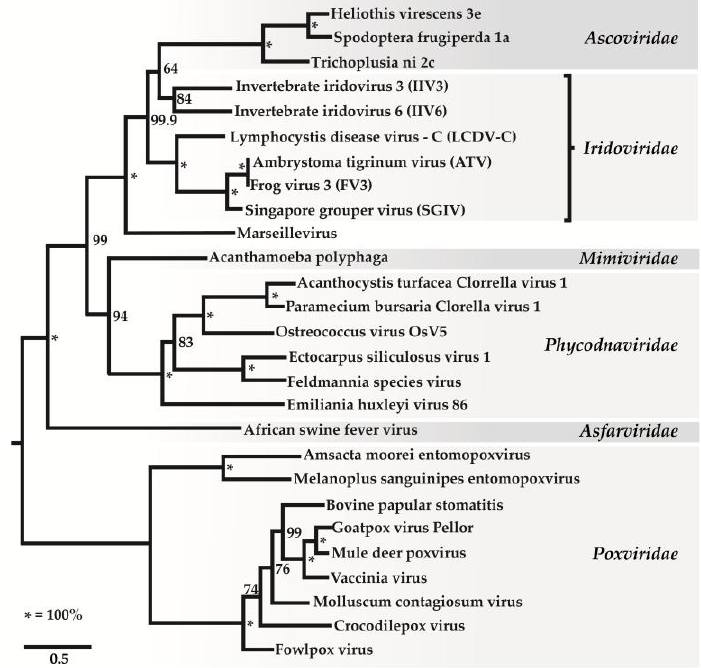
Figure 1. Phylogenetic relationships of iridovirids with other nucleocytoplasmic large DNA viruses A maximum-likelihood tree constructed based on concatenated alignments of 1849 positions of five NCLDV core proteins: A1L/VLTF2 transcription factor, A32 ATPase, D5 type ATPase, DNA polymerase B, and major capsid protein using the TreeFinder program with the estimated site rates heterogeneity and with the WAG (Whelan and Goldman) substitution model. The expected-likelihood weights of 1000 local rearrangements were used as confidence values of TreeFinder tree branches. Scale bar represents amino acid substitutions per site (This figure was used with permission from PNAS [8] and ICTV [4] where it was presented earlier and slightly modified its presentation).